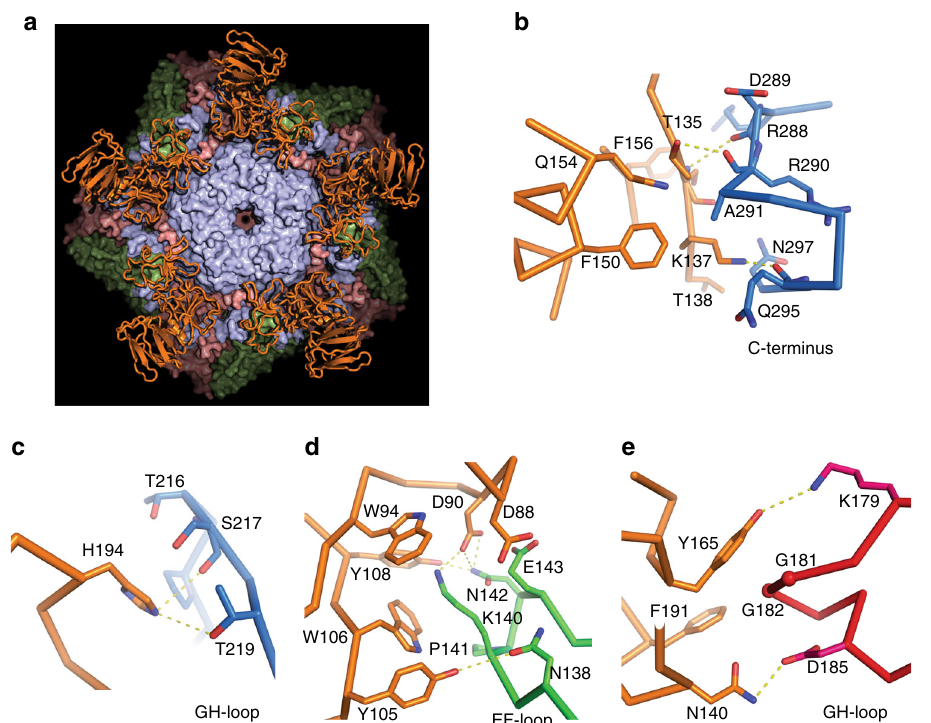
Fig. 4 Details of interactions between CV-A10 and KRM1. a KRM1 (orange ribbons) engaged in the canyon around the icosahedral fi vefold axis of CV- A10. Only a pentamer of the virus is shown with VP1, VP2 and VP3 as pale blue, green and red surfaces, respectively. b – e Interactions of KRM1 with VP1 C- terminus ( b ), VP1 GH loop ( c ), VP2 EF loop ( d ) and VP3 GH loop ( e ) of the virus. The main-chain backbone and sidechains of KRM1 are drawn as orange sticks, and those for CV-A10 as blue, green and red sticks for VP1, VP2 and VP3, respectively.